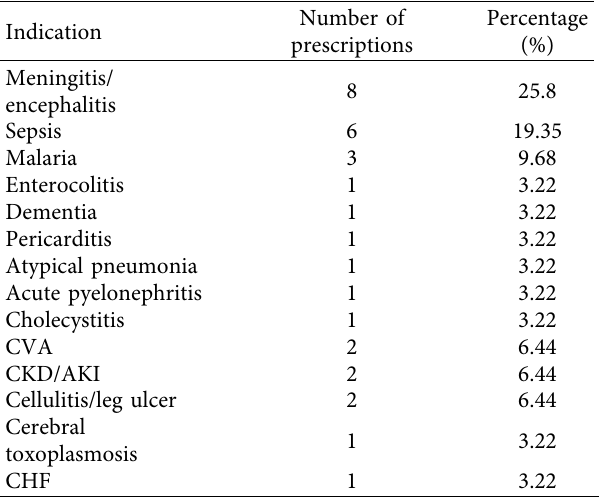
Table 6: Proportions of the indications of ceftriaxone prescribed from the fle